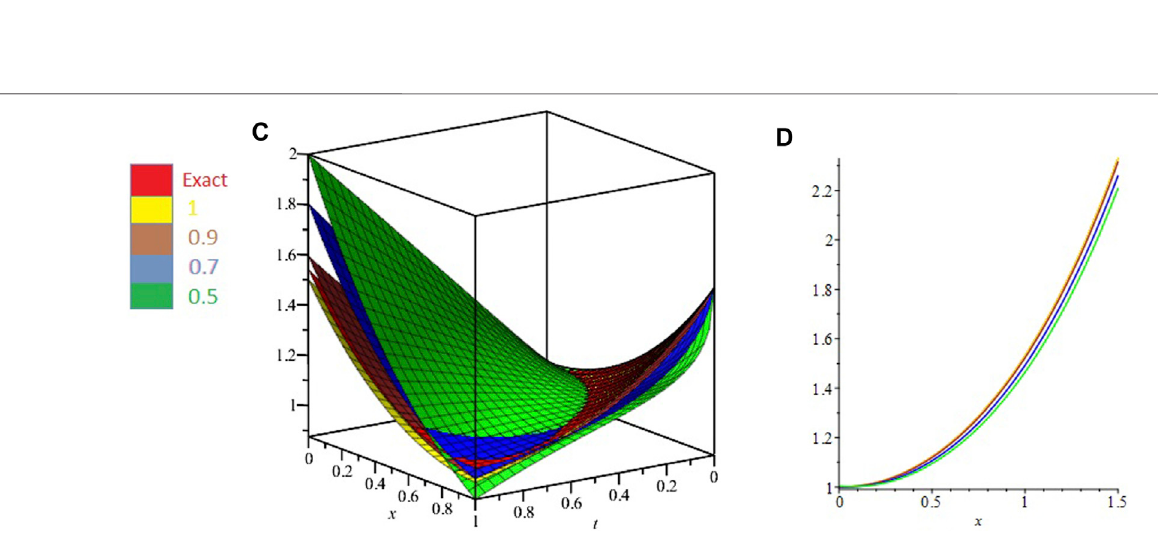
FIGURE 1 | ETDM μ -solution (A) 3D and (B) 2D graph at various values of α and β